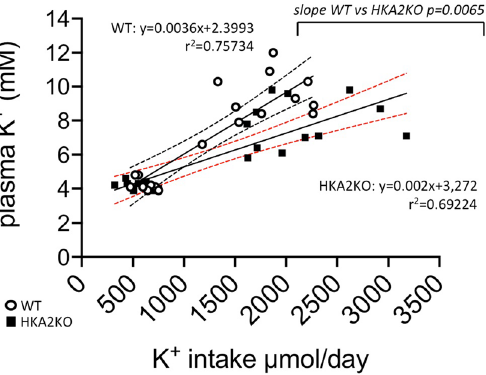
Figure 3. HKA2KO mice exhibit a lower sensitivity to K + intake than WT mice. Relationship between daily K + intake and plasma K + value in N5/6 WT (white circles) and in HKA2KO mice (black squares). Results are shown as individual points fitted with a least squares regression method (straight lines) in a 95% confidence intervals (dotted